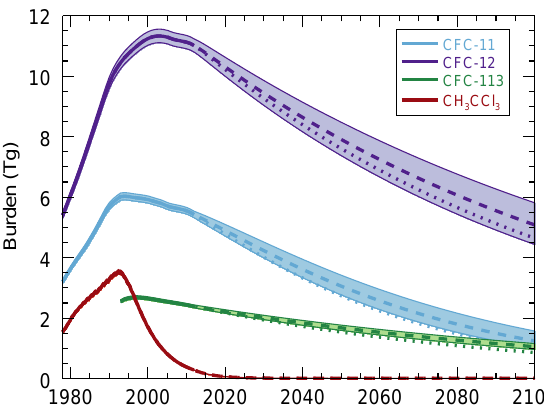
Fig. 4. Historical atmospheric burdens of CFCs and CH 3 CCl 3 (solid lines) and future projections (dashed lines) based on AGAGE observations. Shaded areas indicate 1-sigma uncertainties. Dotted lines show the projections if WMO-recommended lifetimes are